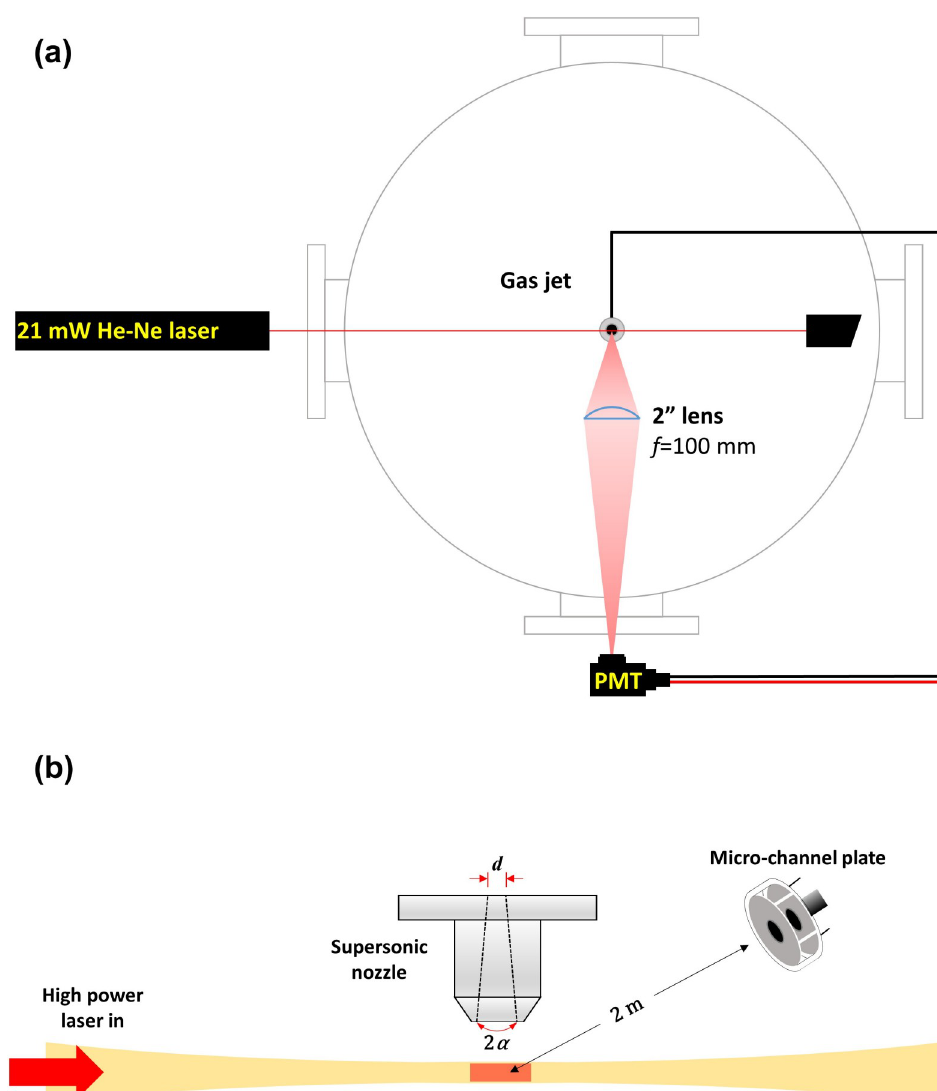
Fig 1. Schematic layout of the experimental setup. Experimental setups for (a) Rayleigh scattering measurements and (b) ion time-of-flight measurements from laser-cluster fusion plasmas. The same nozzle was used for both measurements with an orifice diameter of d = 0.79 mm and an expansion half-angle of α = 5˚.